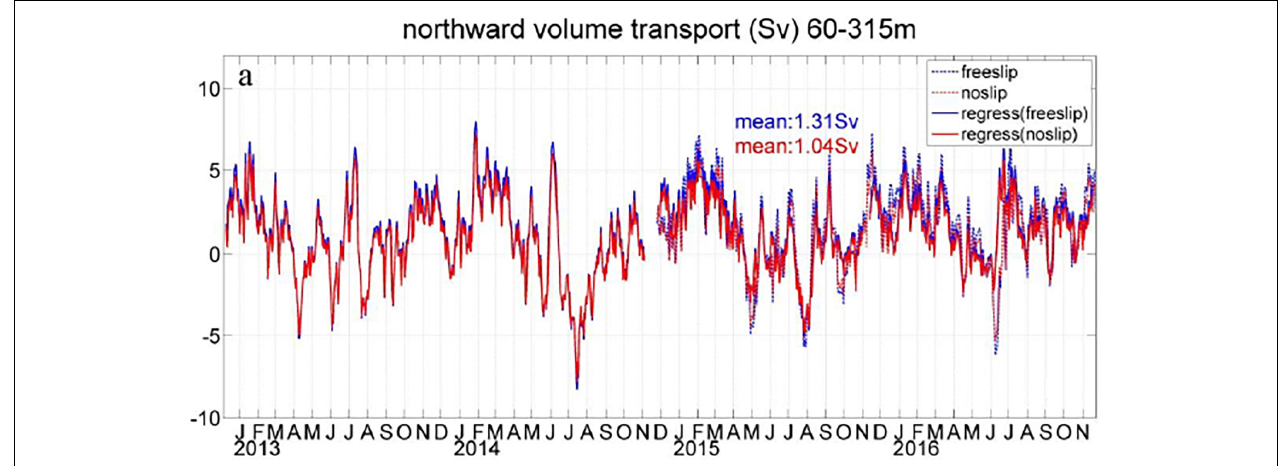
FIGURE 5 | Time series of the Maluku Channel transport (Sv) between 60 and 315 m from three ADCP moorings deployed during 2015–2016 assuming free-slip (red dotted) and nonslip (blue dotted) conditions at the coasts, respectively. Solid blue and red curves are a regression model using the transport and the meridional velocity at the middle mooring that is then used to estimate the transports (from the middle mooring velocity) during 2012–2014 (Figure from Yuan et al.,